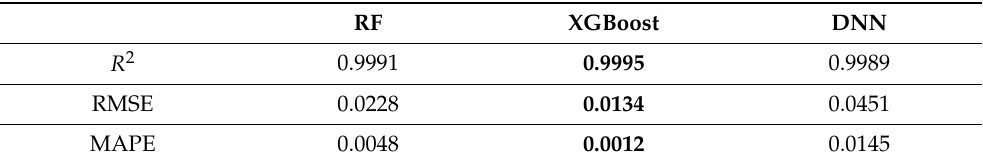
Table 3. Optimal statistical measures for different ML-based regression models trained, validated and tested on the OB-set